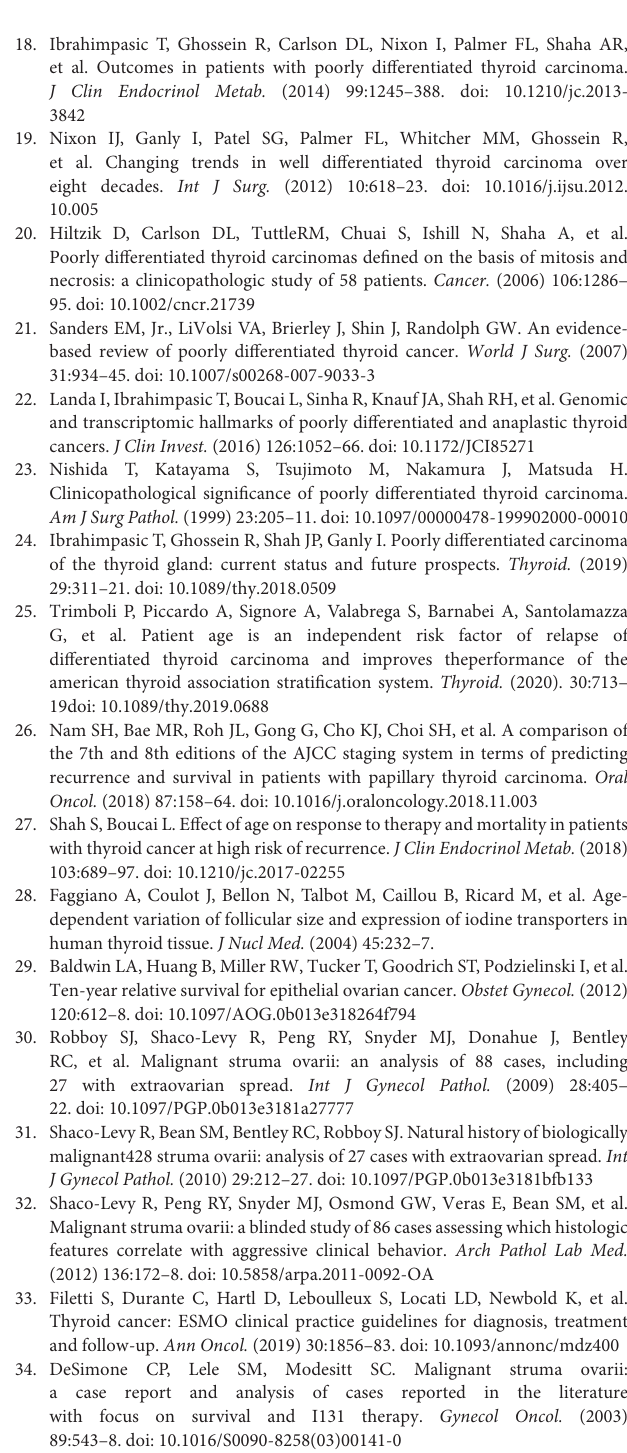
Supplementary Table 1 | Database of our study (A) patients with malignant struma ovarii (MSO) confined to the ovary; (B) patients with metastatic MSO. Supplementary Table 2 | The univariate and multivariate analysis of clinical outcomes.